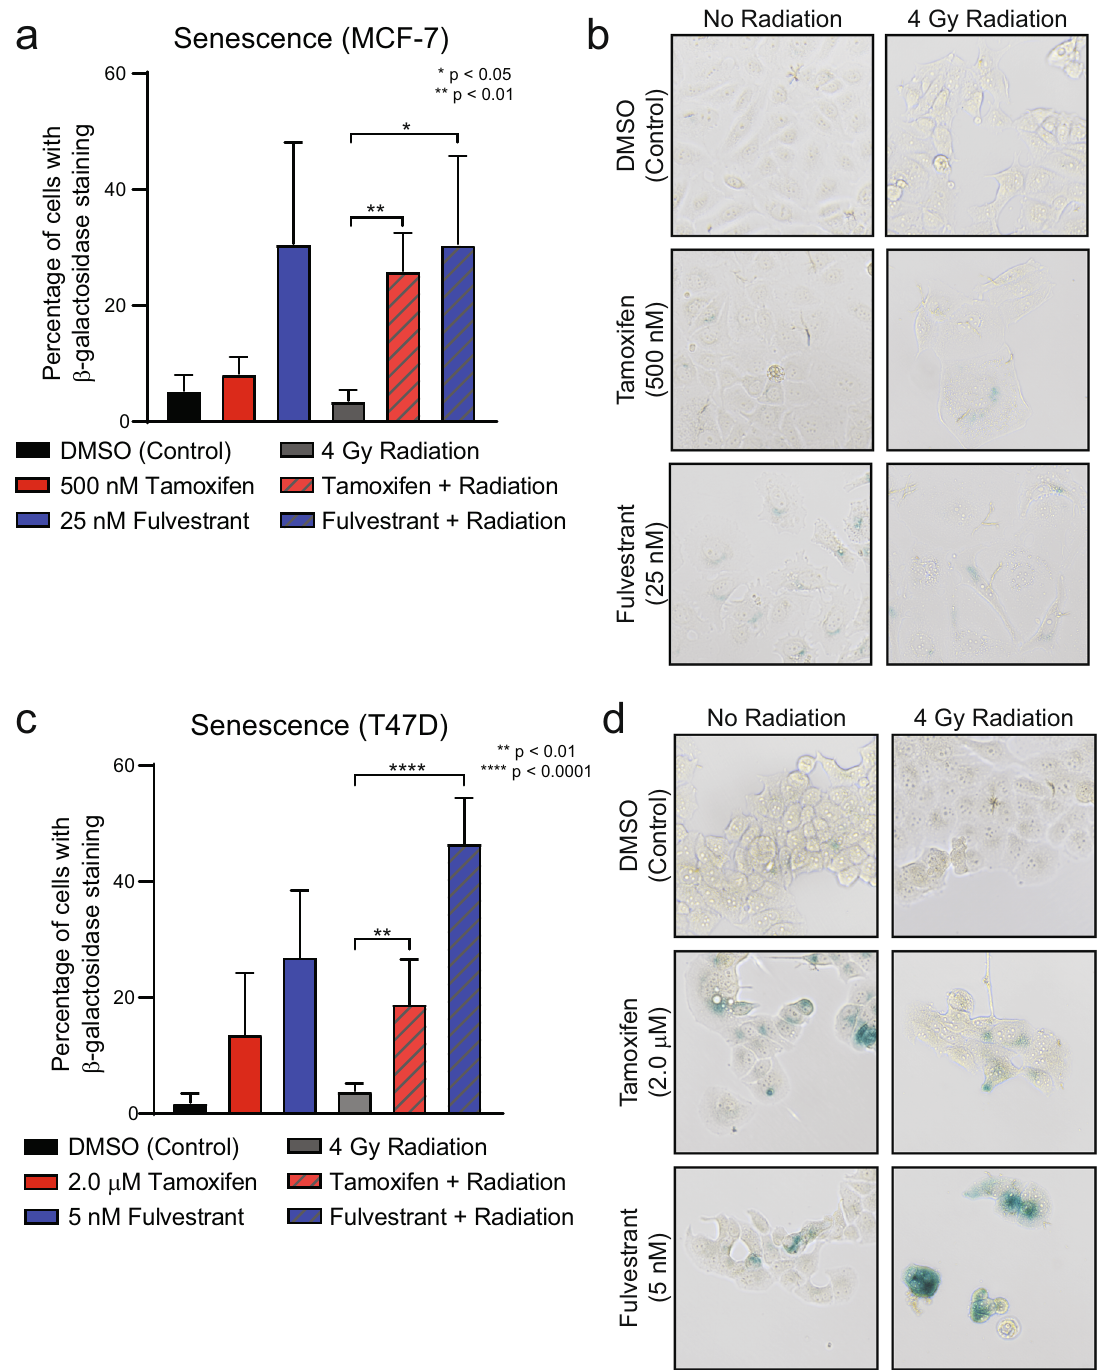
Fig. 4 Endocrine therapies in combination with radiation induce senescence. MCF-7 cells were treated with 500 nM tamoxifen or 25 nM fulvestrant for one hour prior to 4 Gy radiation and stained for β -galactosidase at 14 days post-RT. Quanti fi cation of cells positive for β -galactosidase was performed for MCF-7 ( a ) and T47D ( c ) cells. Representative images of β -galactosidase staining are shown for each cell line ( b , d ). Data from three or four replicate experiments are graphed as mean ± SD. (* P < 0.05; ** P < 0.01; **** P <